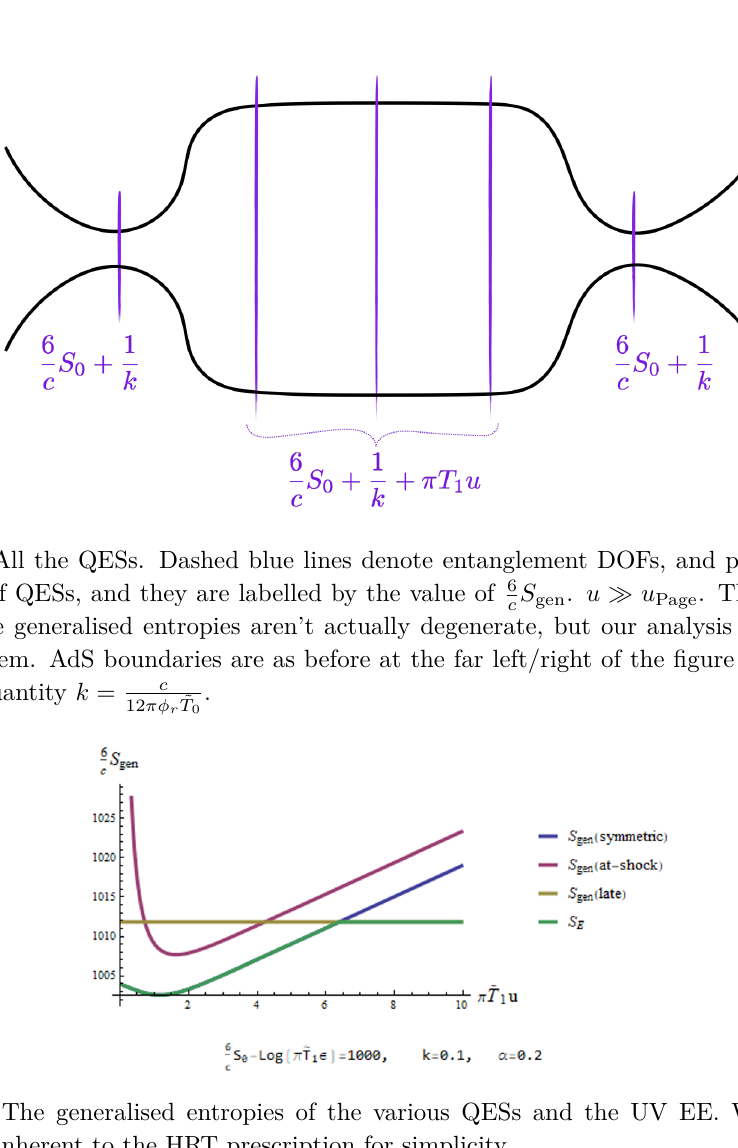
Figure 17. The generalised entropies of the various QESs and the UV EE. We have ignored uncertainties inherent to the HRT prescription for